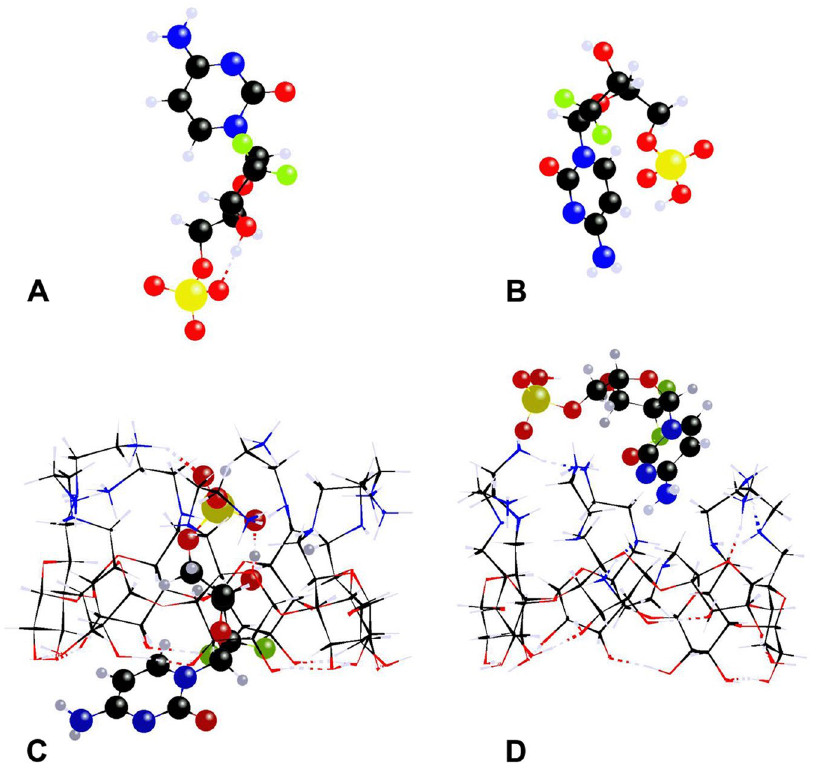
Figure 2. The lowest-energy conformers of dFdCMP − 2 ( A , gg) and dFdCMP − 1 ( B , tg) and the most stable complexes of 1 H 77 + via inclusion of dFdCMP − 1 ( C ) and external association of dFdCMP − 2 ( D ) at the PM7- COSMO level of theory. Color code: C (black); H (off-white); N (blue); O (red); F (green); P (dark